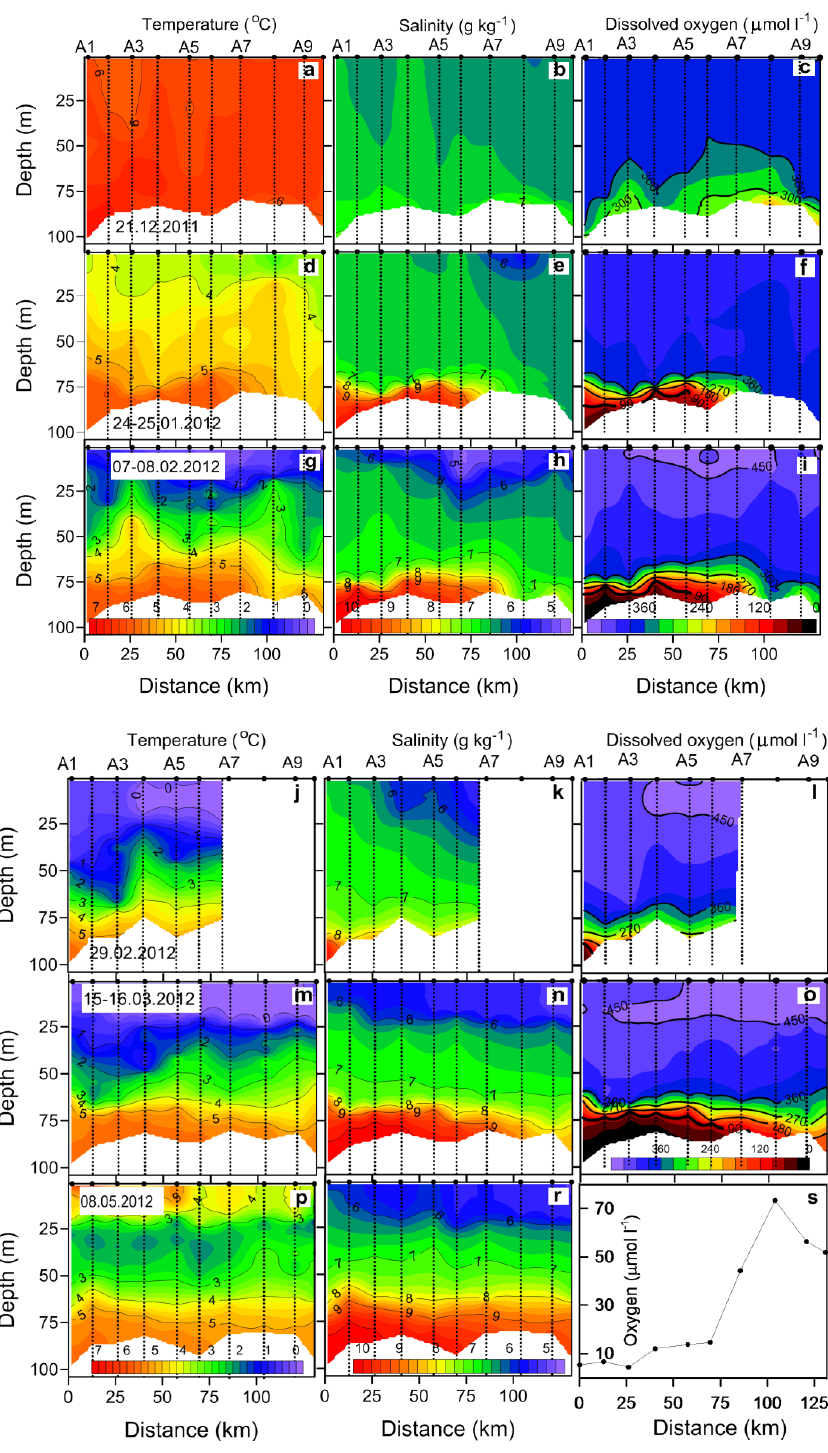
Figure 3. Vertical sections of temperature (interval 0.25 ºC), salinity (interval 0.25 g kg –1 ) and dissolved oxygen (interval 30 µmol l –1 ) on 21 December 2011 (a, b, c), 24–25 January 2012 (d, e, f), 7–8 February (g, h, i), 29 February (j, k, l), 15–16 March (m, n, o) and 8 May (p, r) measured along the thalweg of the gulf. A thick contour line marks the dissolved oxygen concentration of 90 µmol l –1 . On 8 May, only near-bottom layer dissolved oxygen concentrations were available (s). Values on the x -axis indicate distance from the westernmost station (see Fig. 1).